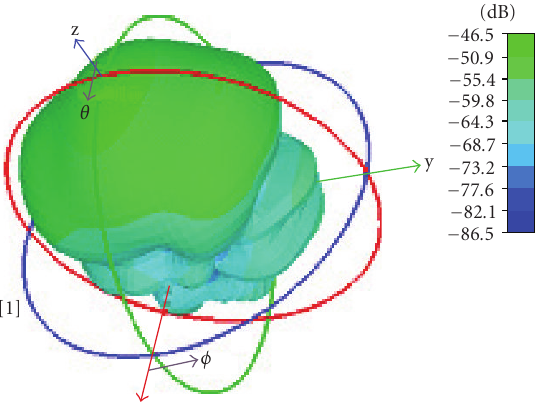
Figure 5: Gain of the antenna placed inside the cavity.